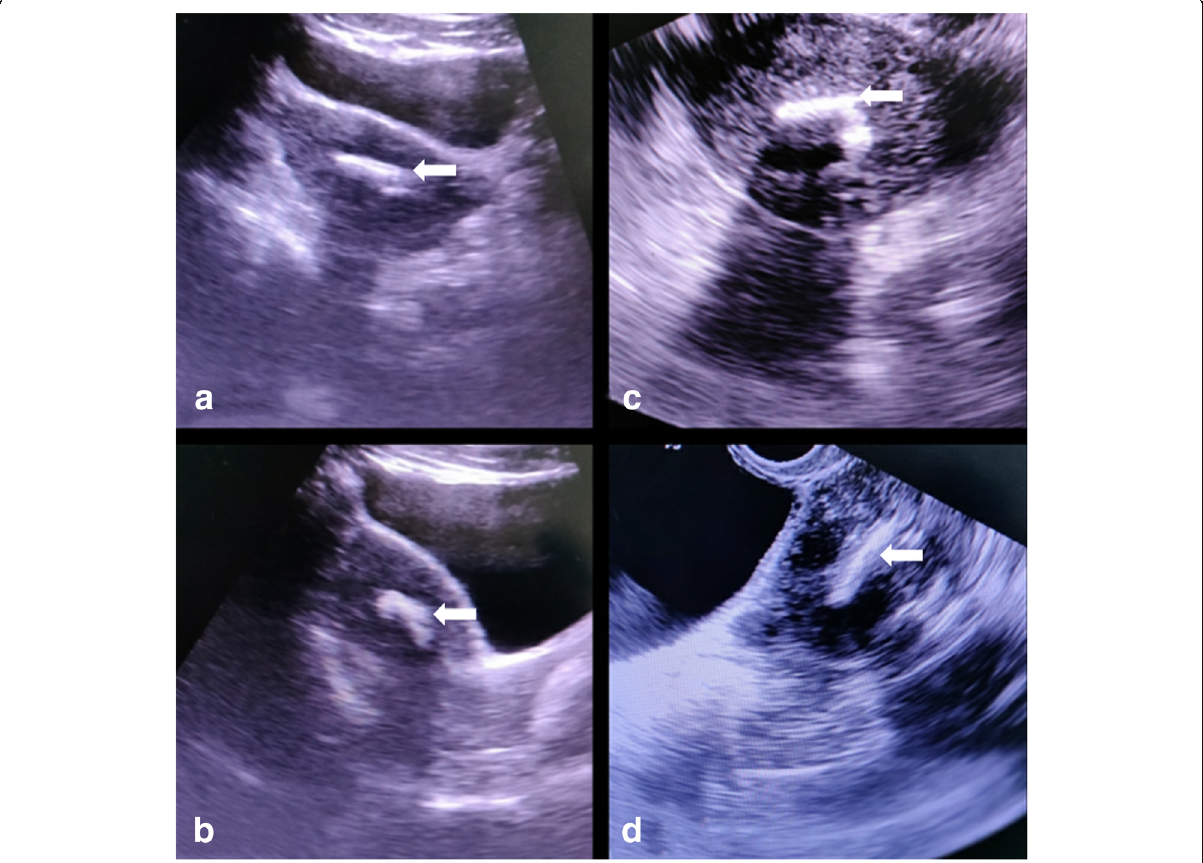
Fig. 1 Transabdominal axial ( a ) and sagittal ( b ) sonogram in a 27-year-old infertile patient revealing thick linear hyperechogencity (arrows) in endometrial canal within the uterine corpus. Transvaginal axial ( c ) and longitudinal ( d ) ultrasound images confirming the findings of transabdominal ultrasound. Subsequent HPE proved the diagnosis of